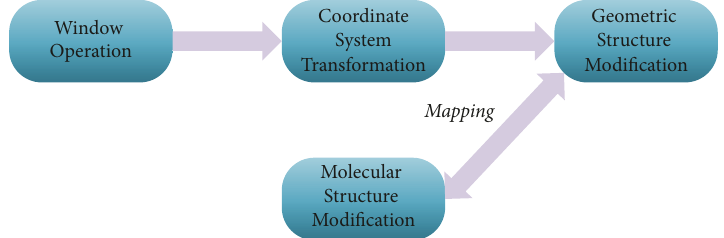
Figure 10: Process of interactive model